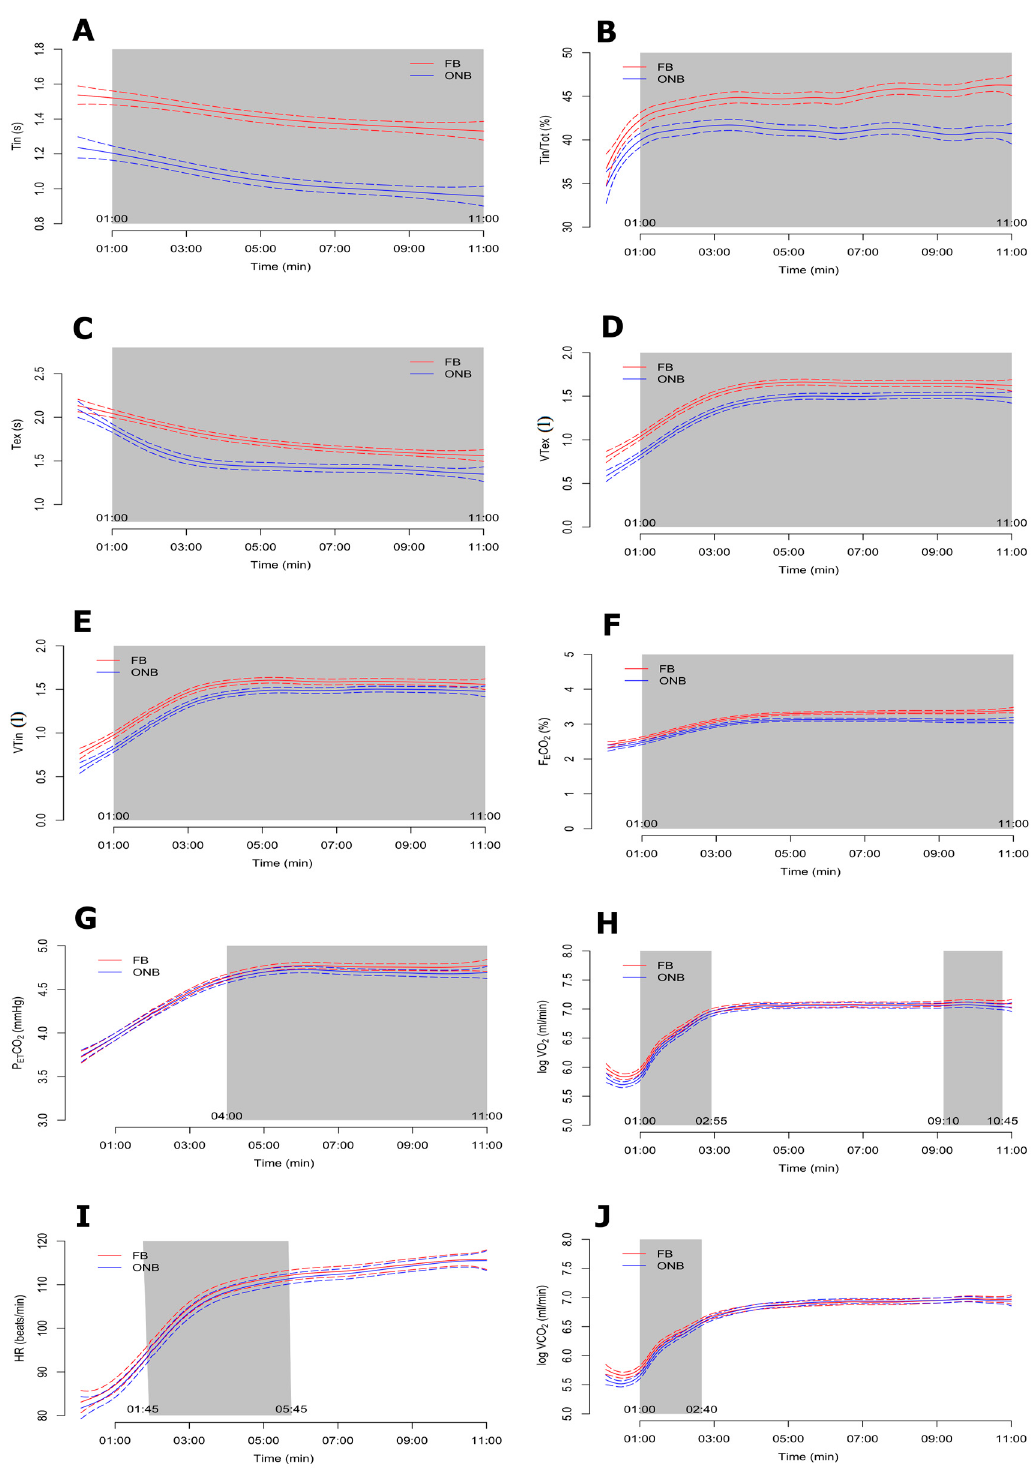
Figure 2. Bayesian functional ANOVA plots for FB > ONB group variables: inspiration time (Tin) ( A ), inspiratory time fraction (Tin / Tot ) ( B ), expiration time (Tex) ( C ), expiratory tidal volume (VTex); ( D ), inspiratory tidal volume (VTin) ( E ), fraction of expired carbon dioxide (FECO 2 ) ( F ), end-tidal partial pressure of carbon dioxide (PETCO 2 ) ( G ), oxygen uptake (VO 2 ) ( H ), heart rate (HR) ( I ) and carbon dioxide production (VCO 2 ) ( J ).